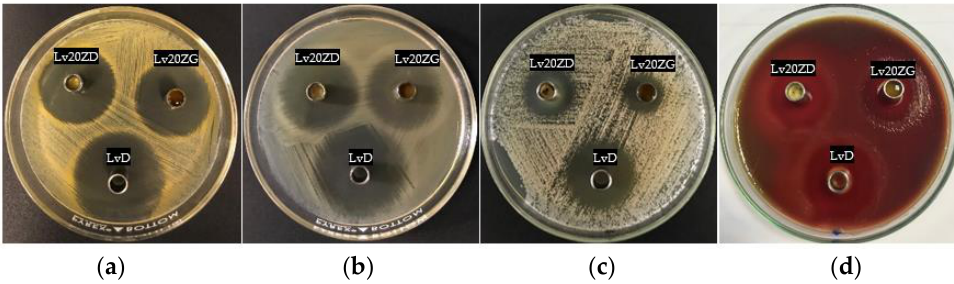
Figure 8. Photographs of the inhibition zone of Lv20ZD (upper-left corner cup) and Lv20ZG (upper- right corner cup) ISG formulations against S. aureus ( a ), E. coli ( b ), C. albicans ( c ), and P. gingivalis ( d ) and the control group (LvD) at the bottom cup. Table 4. Inhibition zone diameters of DMSO, GF, and Lv-loaded zein-based ISG formulations against S. aureus , E. coli, C. albicans, and P. gingivalis ( n = 3).